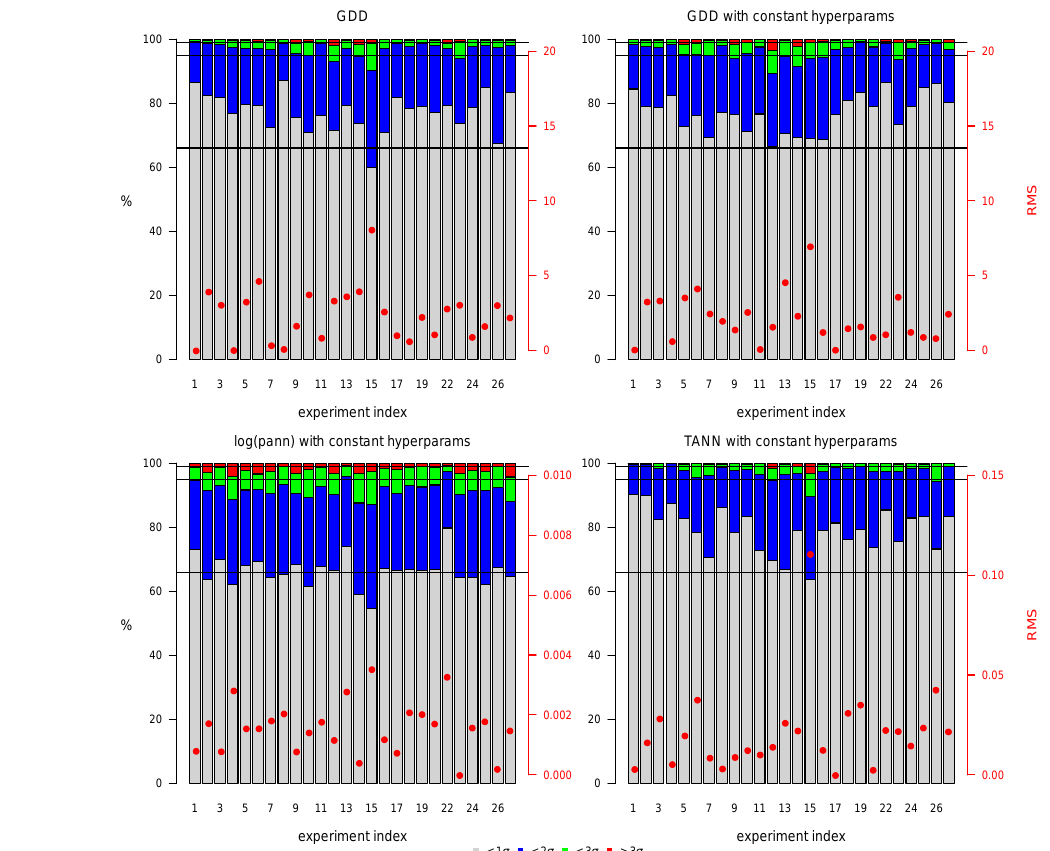
Figure 5. Evaluation of the PC emulators. The bars give the fraction of grid points for which the emulation correctly predicts the value of the experiment left out of the training set, within the 66th, 95th, and 99th inner quantiles of the distribution. The horizontal lines indicate the theoretical position of the percentiles for well-calibrated emulators. Dots provide root mean squares of the differences between predicted and actual values. The graphical layout is adapted from the recommendation of the “Modelling Uncertainty in Computer Model” project,